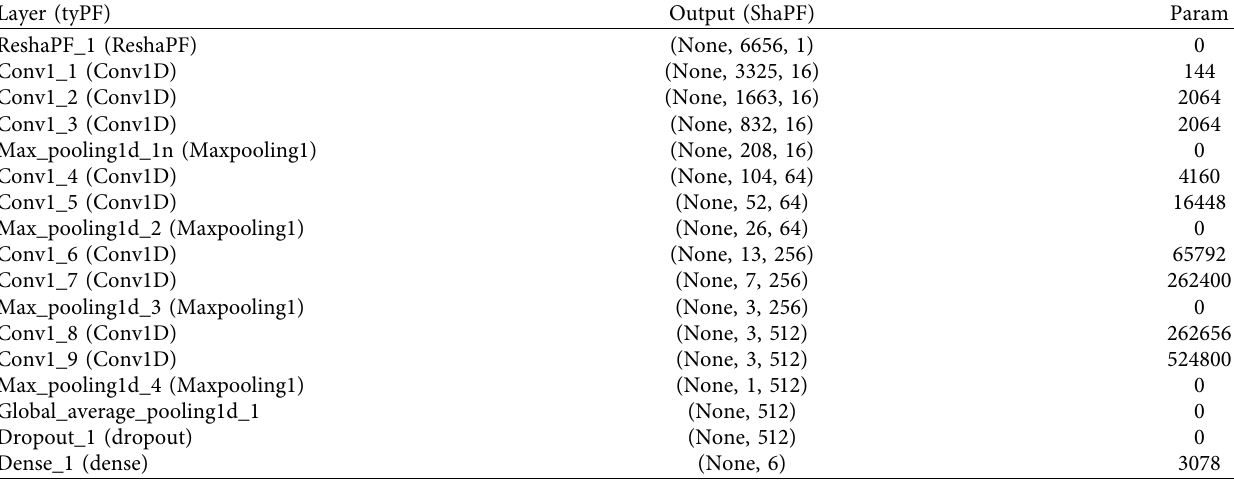
Table 4: Parameters of CNN based on LMD.